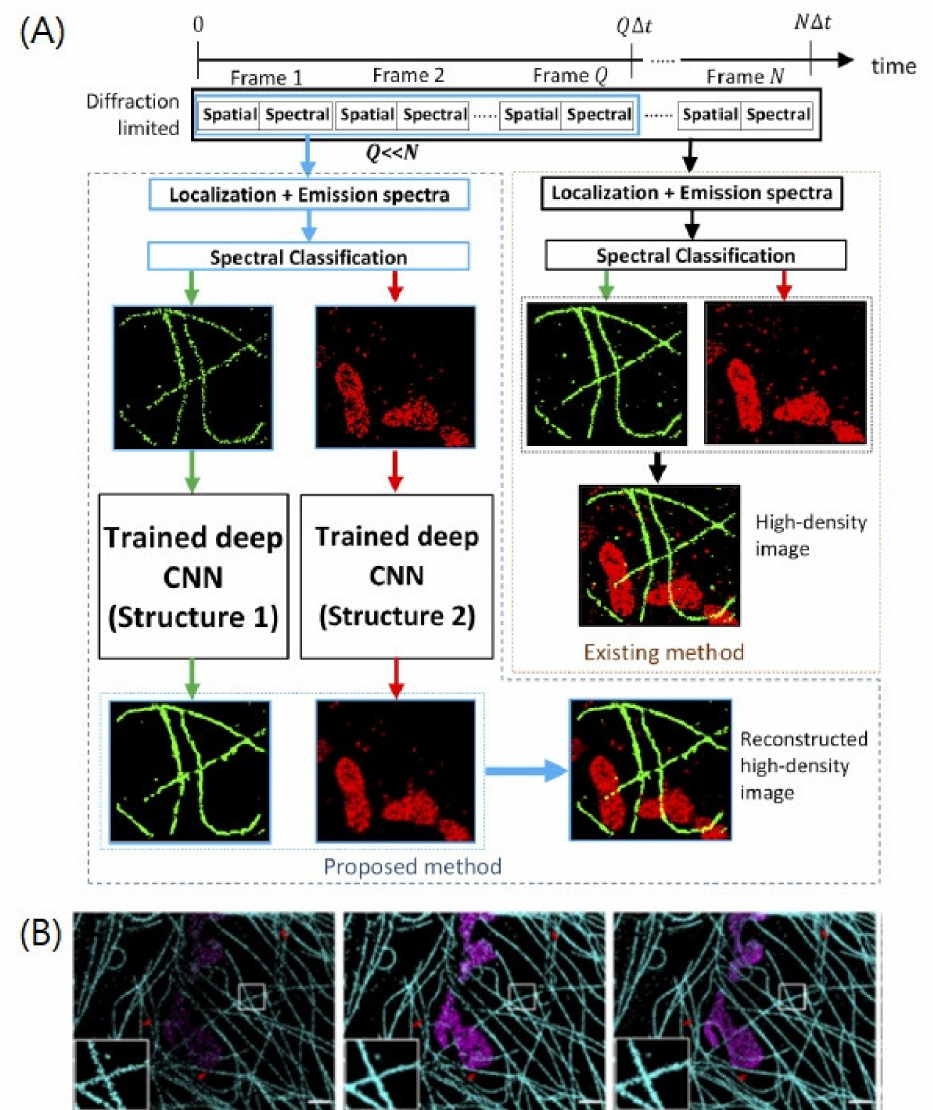
Figure 5. A deep-learning-based method for constructing high-density super-resolution image from a low-density image. ( A ) The trained deep CNNs reconstruct the high-density multicolor image using a small number of image frames. ( B ) The two-color STORM images of AF647 labeled tubulin (cyan) and CF660C labeled mitochondria (magenta) in a COS-7 cell. (Left) Reconstructed image from 3000 frames by existing fitting method. (Middle) Reconstructed image from 3000 frames by deep CNN. (Right) Reconstructed image from 3000 frames by existing fitting method from 19,997 frames. Scale bar = 1.5 µ m. Adapted from the article of [36] under the OSA Open Access Publishing